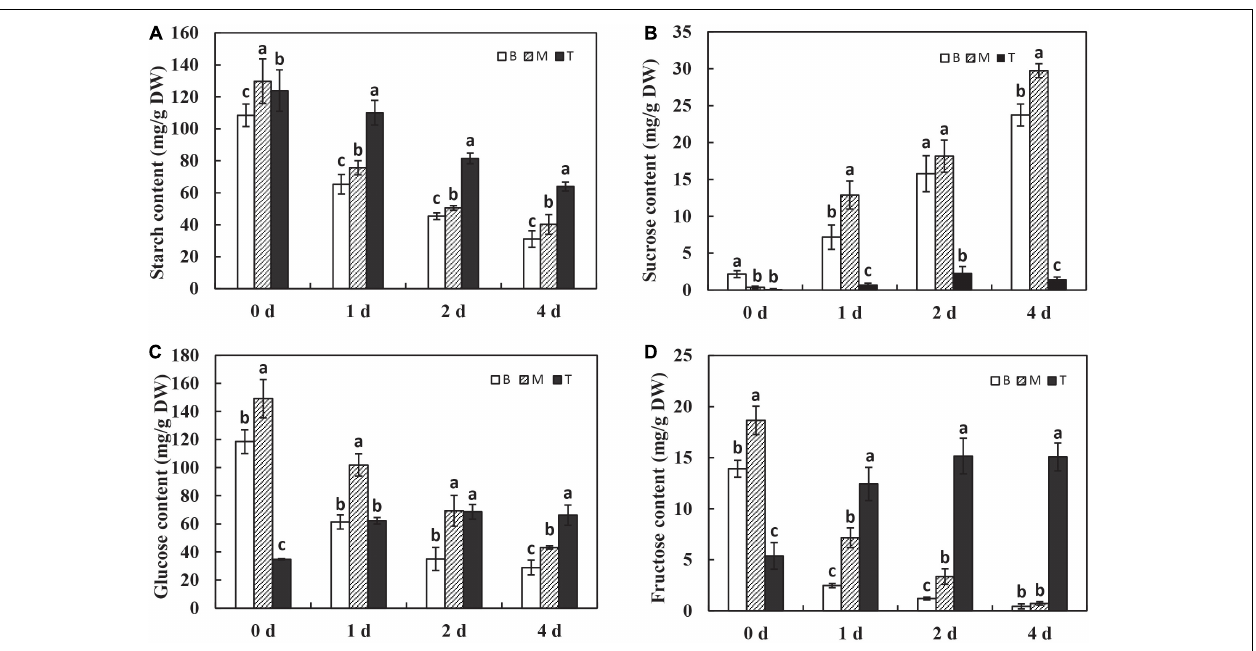
FIGURE 2 | Changes of carbohydrates during dodder shoots growth in vitro. The variations of starch (A), sucrose (B), glucose (C), and fructose (D) in different segments of in vitro dodder shoots (B, basal stems; M, middle stems; T, shoot tips). The values are means, and the vertical error bars are SD ( n = 3). Different letters at the same time point represent significant difference protected with Fisher’s LSD at P <